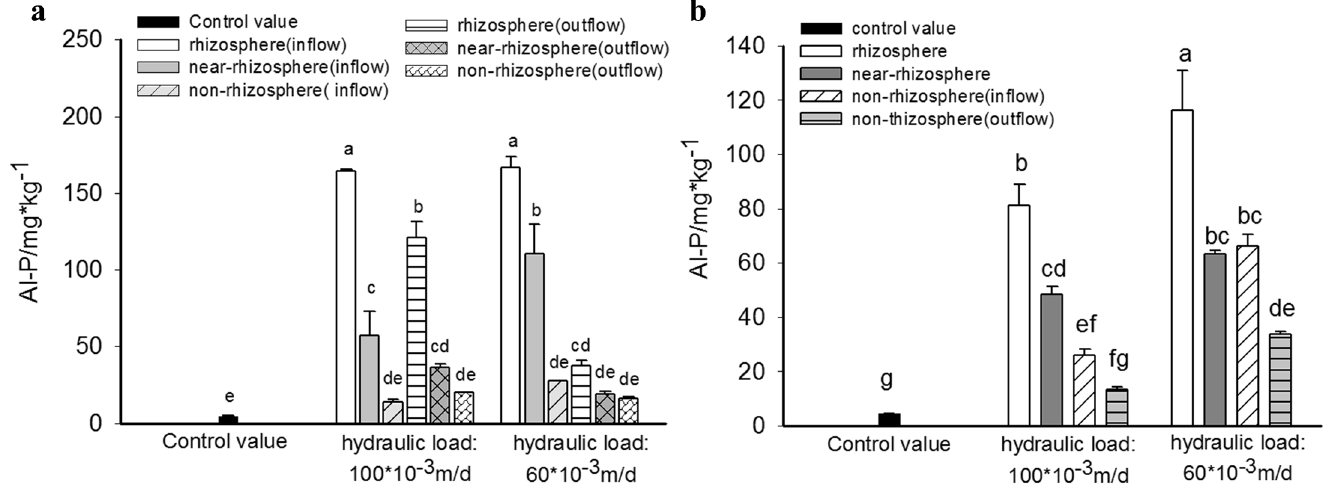
Fig 5. Content of Al-P in substrates in different zone of HSSF CWS(a) and VSSF CWS(b) with high and low hydraulic loading rate.